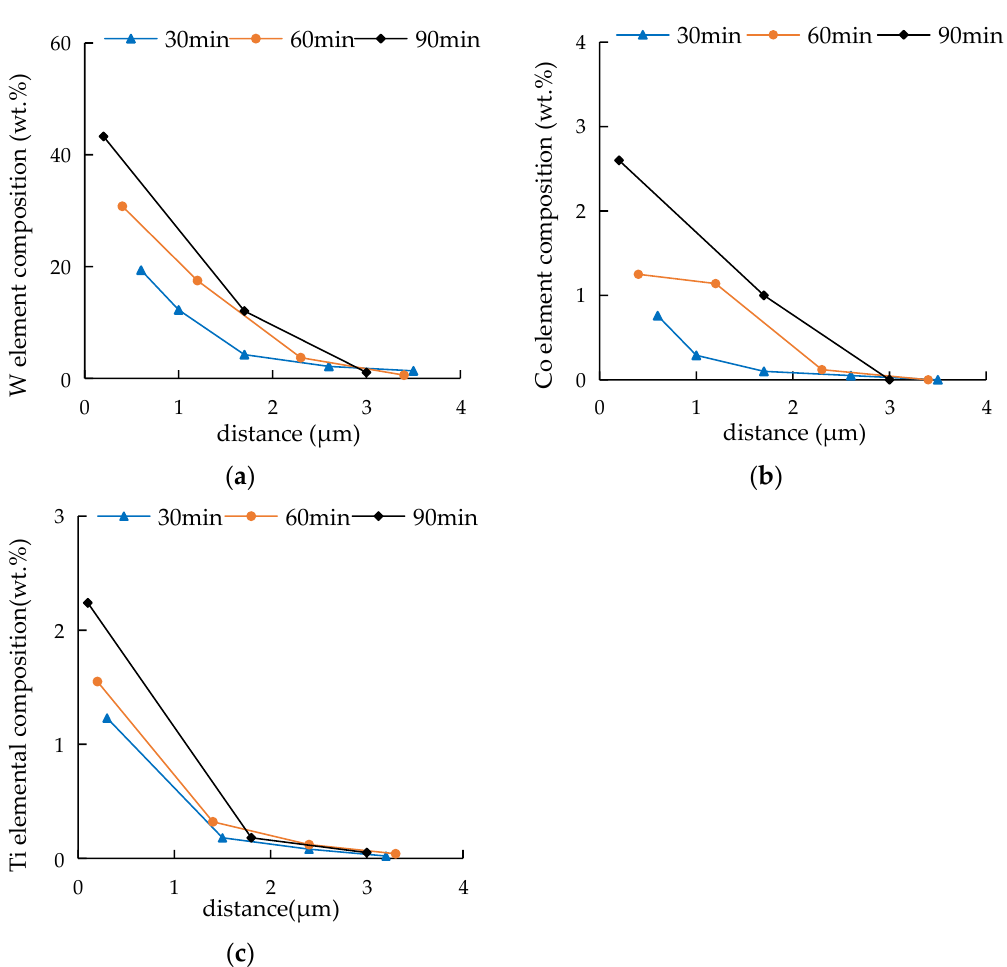
Figure 10. Element diffusion between the cemented carbide and the Ti6Al4V for different holding times. ( a ) Diffusion of the W element; ( b ) Diffusion of the Co element; ( c ) Diffusion of the Ti element.